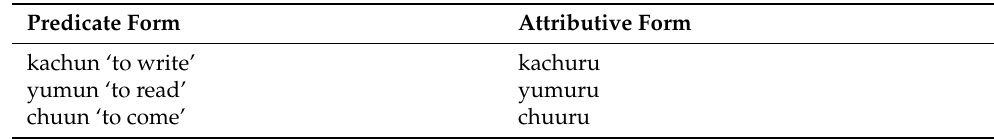
Table 9. Predicate form and attributive form.